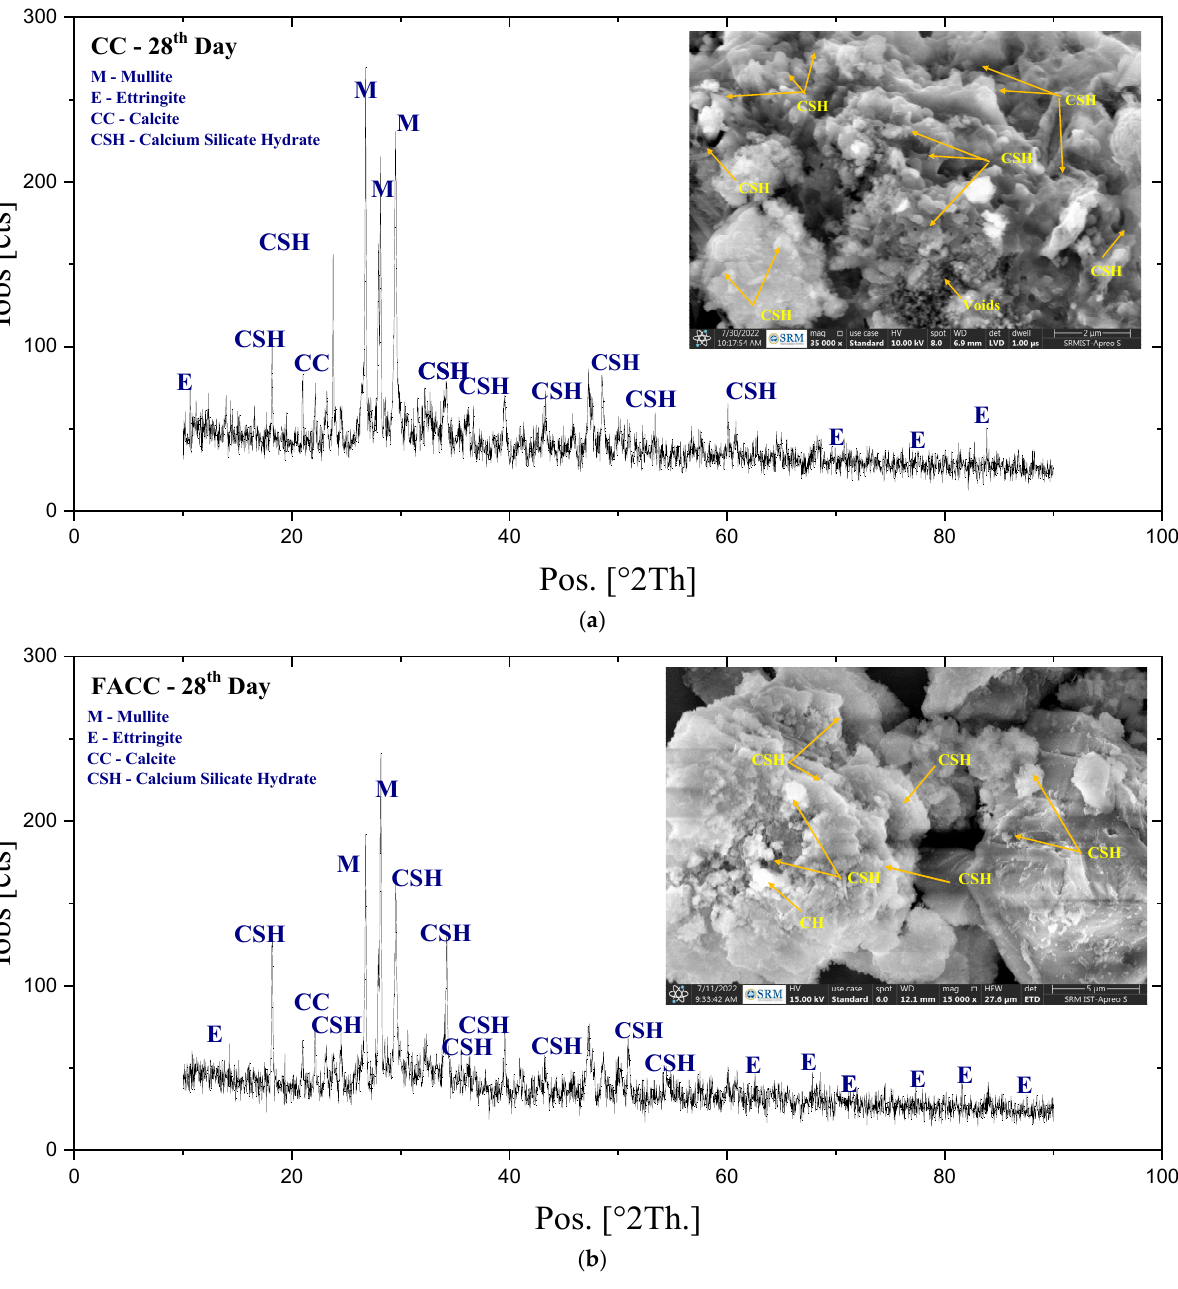
Figure 13. XRD and SEM ( a ) CC ( b ) FACC on the Twenty-Eighth Day of Testing. In Figure 14, an indication of a thin layer of hydration product could be observed. This thin layer over the surface of the FAC could indicated the later-ages strengthening bond between aggregates. When compared to CC, the enhancement of the paste micro- structure of FACC is not only due to its pozzolanic reaction, but it could be the reason for the effective filler effect of the FAC as fine aggregate. Therefore, this results in the ob- Table struction of voids or pores in the concrete mix. We can conclude the overall microstruc- tural behaviour is not affected due to the addition of FAC in the concrete, and that it is also similar to that of the normal concrete performance. Additionally, a systematic for- mation of CSH networks is formed in both CC and FACC mixes. Hence, the replacement of M Sand by FAC does not affect the conventional cement hydration process.